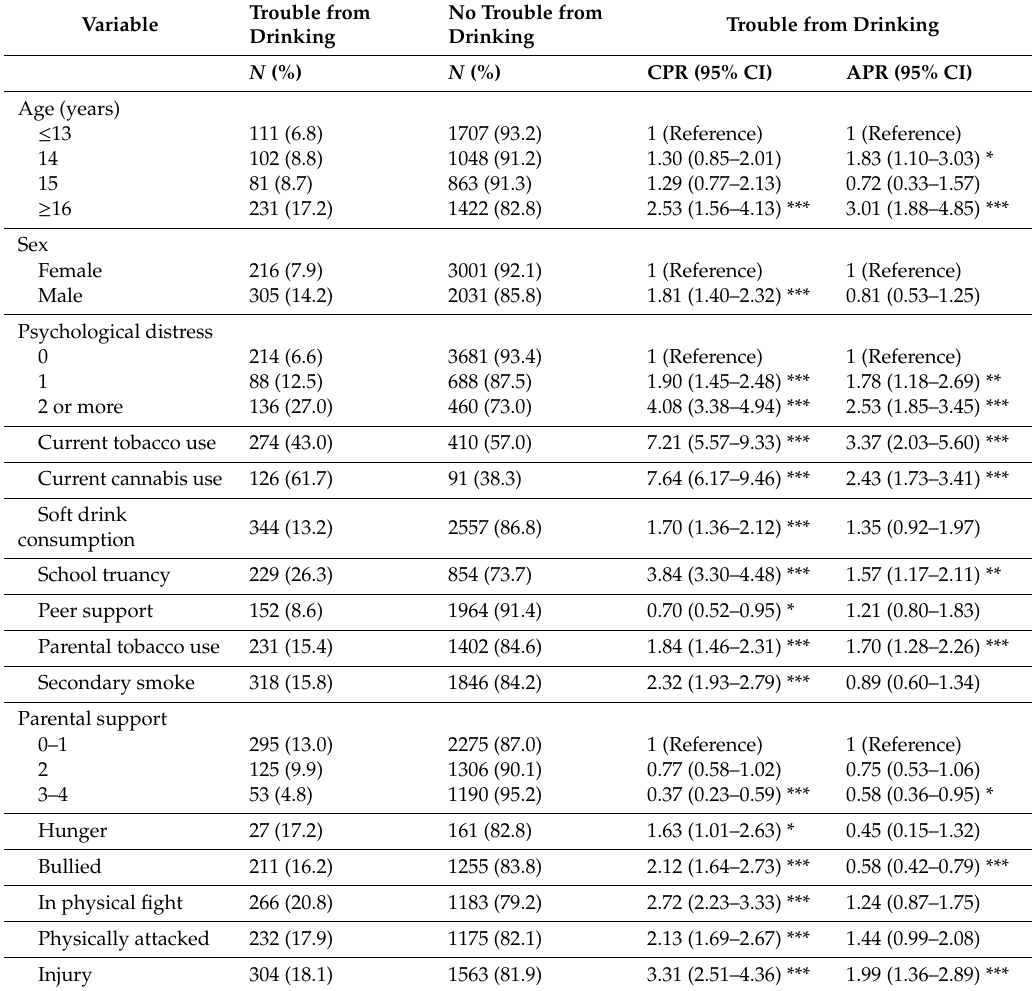
Table 6. Associations with trouble from